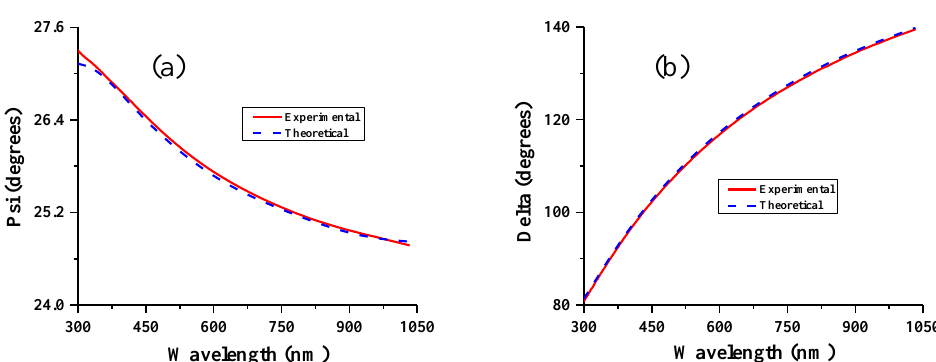
Figure 3. Experimental and calculated ellipsometry angles ( a ) for ψ and ( b ) for ∆ ; were obtained for Cr (2 nm) / NiFe (20 nm) films with a 70 ◦ incidence angle at room temperature. The measured and modelled values are represented with solid and dashed lines, respectively.